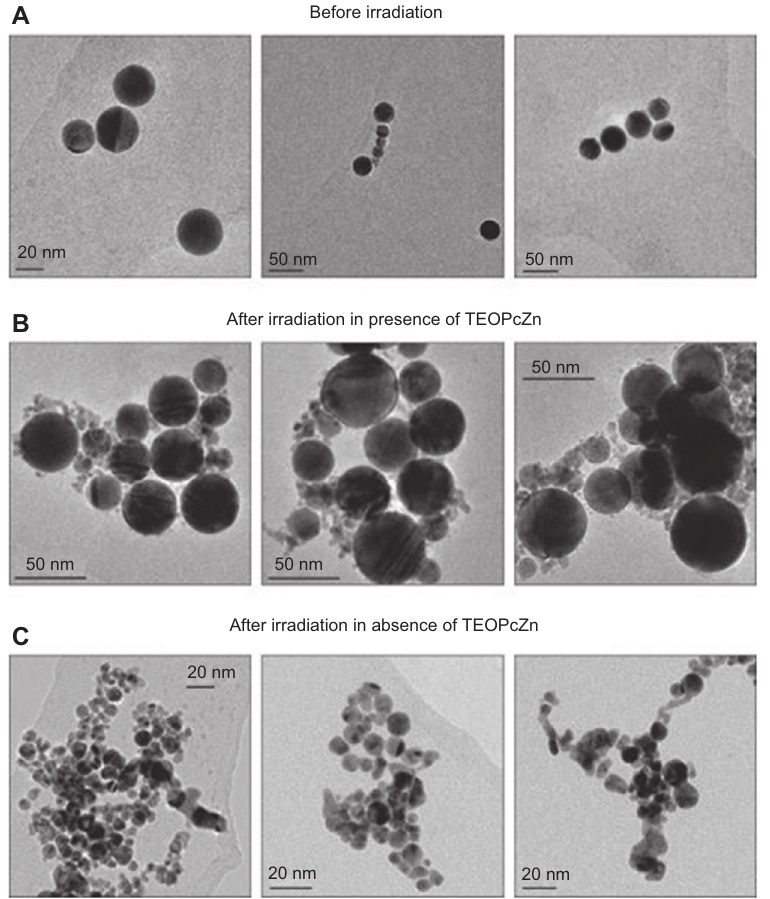
Figure 20 TEM images of AuNP before (A) and after laser irradiation in the presence (B) and absence (C) of zinc phthalocyanines (reprinted with permission from [109]). Copyright 2009, American Chemical